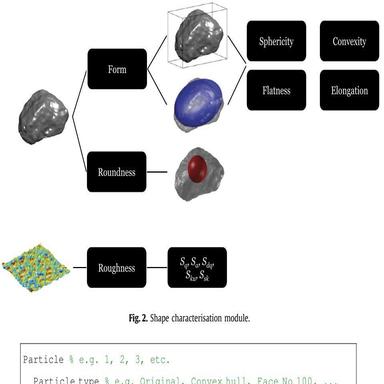
Object-oriented structure of SHAPE.